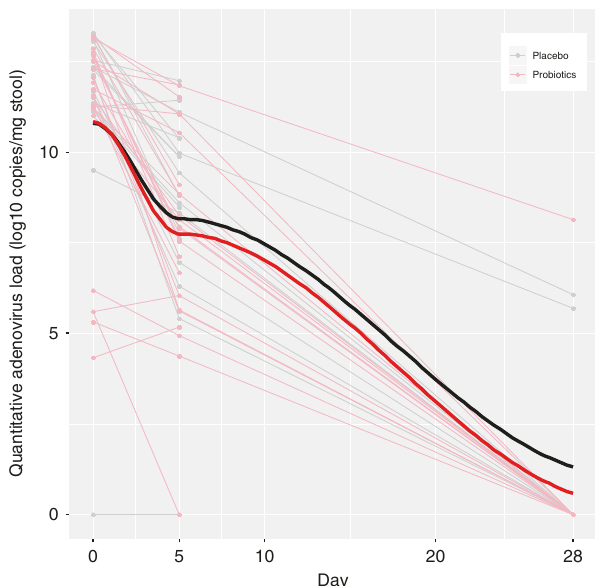
Fig. 4 Change in norovirus viral load quantity in stool over time, compared between probiotic and placebo groups. Stool Log10 transformed copies of norovirus by treatment group [probiotic ( N = 34) vs. placebo ( N = 47)] across time (in days) following randomization on the x -axis. Thin light gray lines refer to patients provided placebo, this red lines refer to those provided probiotic; thick black and red lines to locally weighted smoothing lines respectively The two-sided P -value represents the result of a linear mixed effect model with random intercepts (subjects random effect) comparing placebo (reference group) vs. probiotic on viral load, including time and treatment group variables, and an interaction term for the latter two. Source data are provided as a Source Data fi le. Norovirus (mean difference: 0.16; 95% CI: − 0.81, 1.14; P =